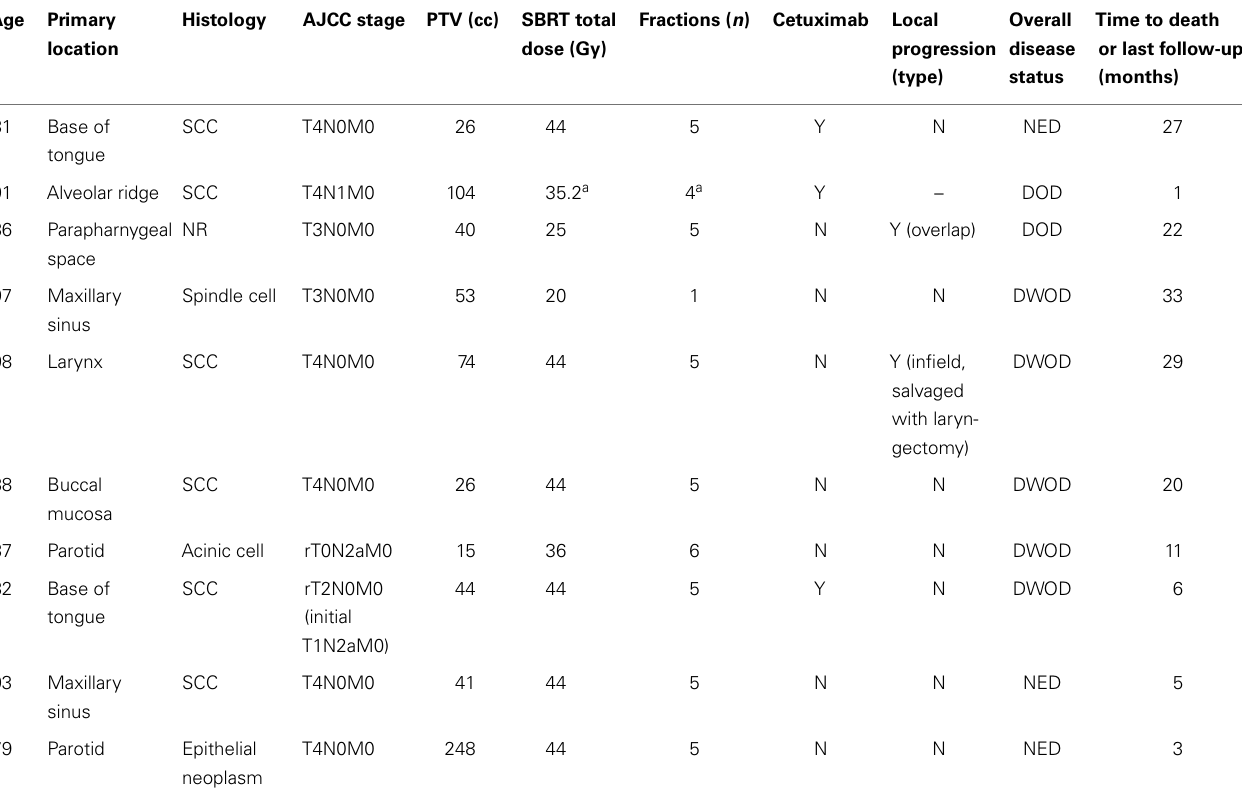
Table 2 | Description of definitive treatments and outcomes .